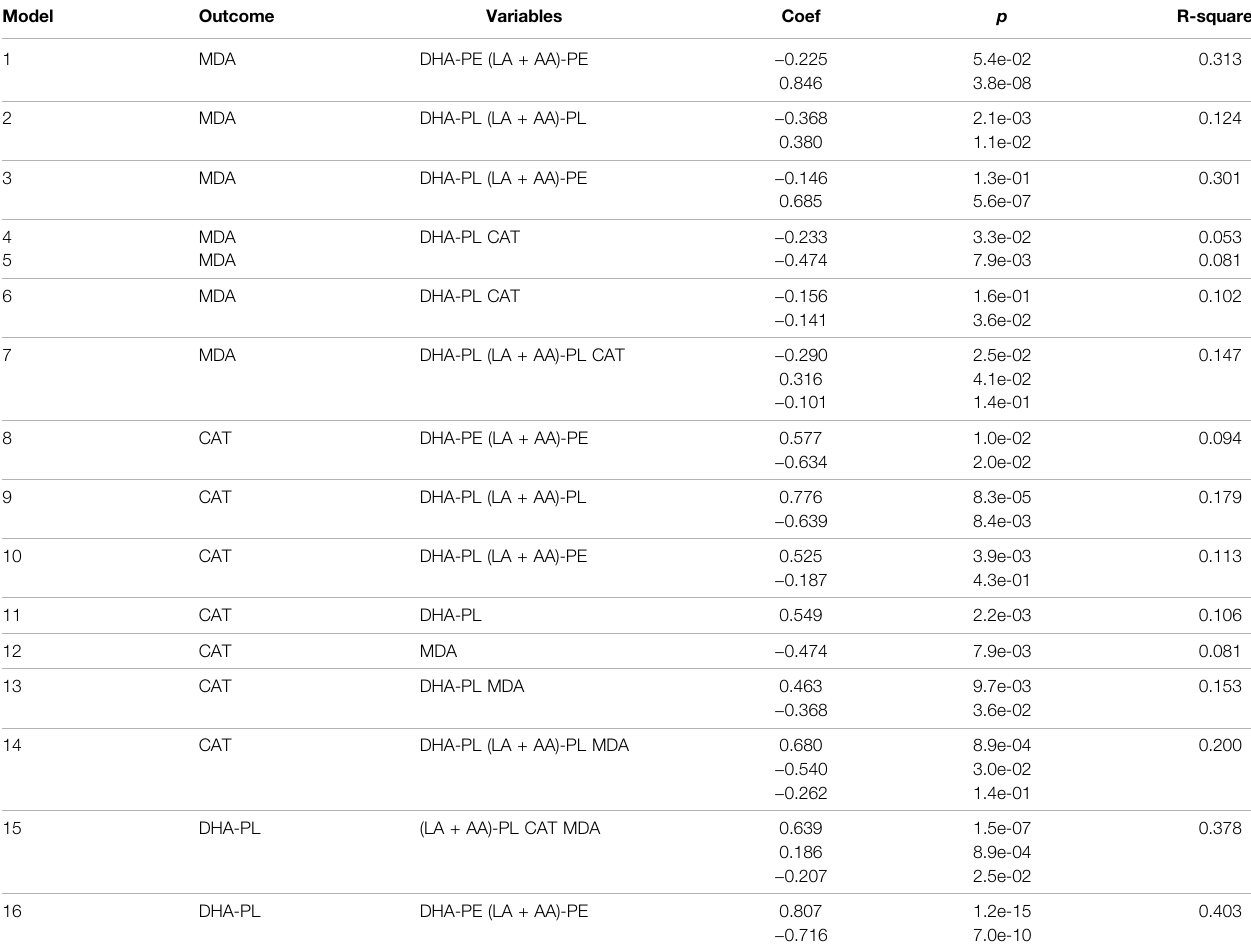
TABLE 3 | Multivariate analyses of selected serological markers associated with catalase and malondialdehyde.